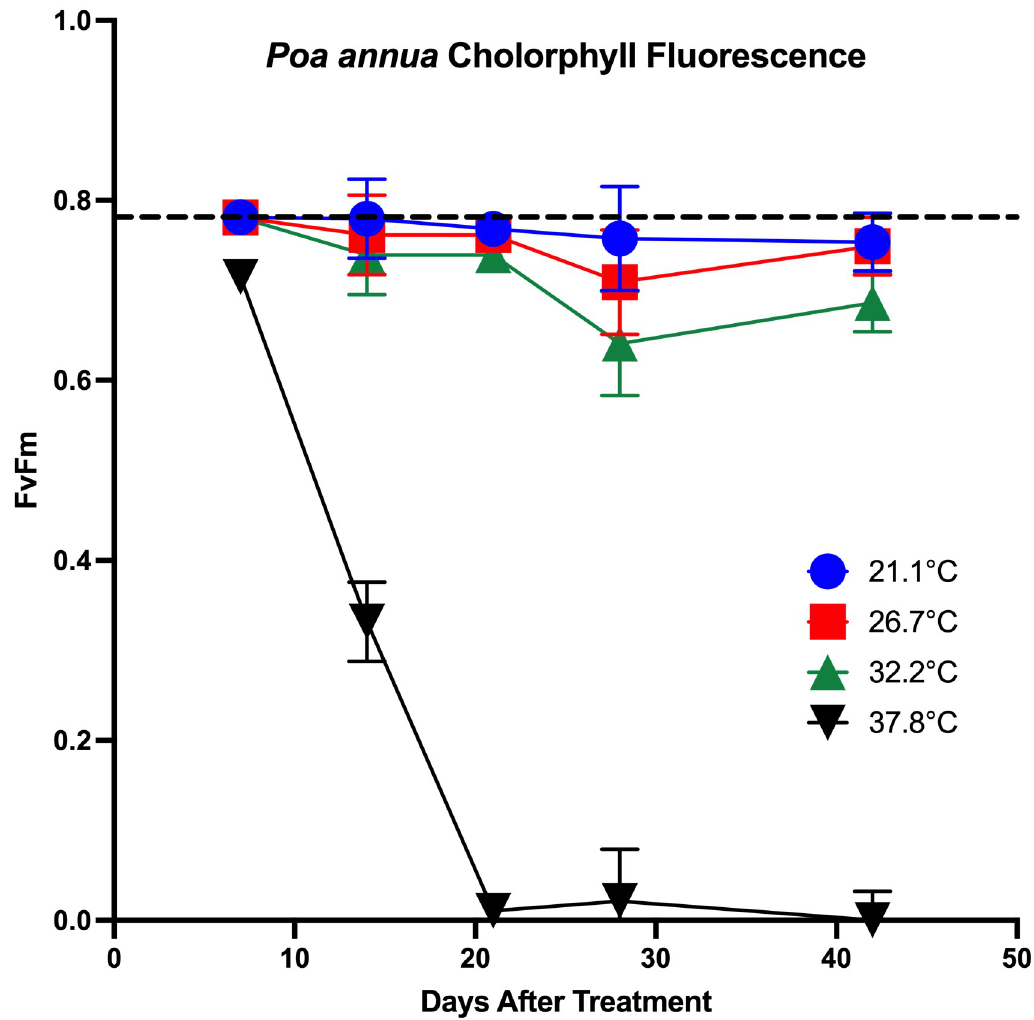
Fig 5. Photochemical efficiency was evaluated by measuring chlorophyll fluorescence (Fv/Fm) twice per Poa annua plant using a fluorometer. Measurements were taken once per week from plants subjected to soil temperatures of 21.1, 26.7, 32.2, or 37.8˚C imposed via water baths. The dotted line indicates optimal chlorophyll fluorescence of